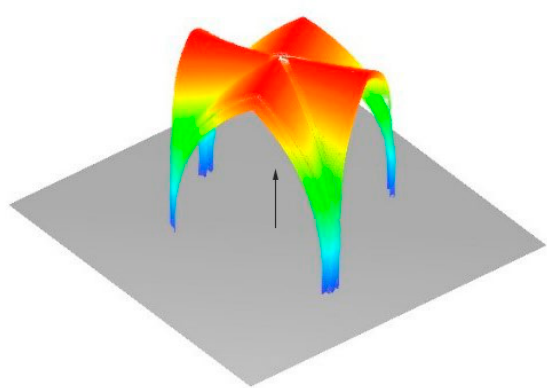
Figure 3: Comparison of the vault G1 with horizontal